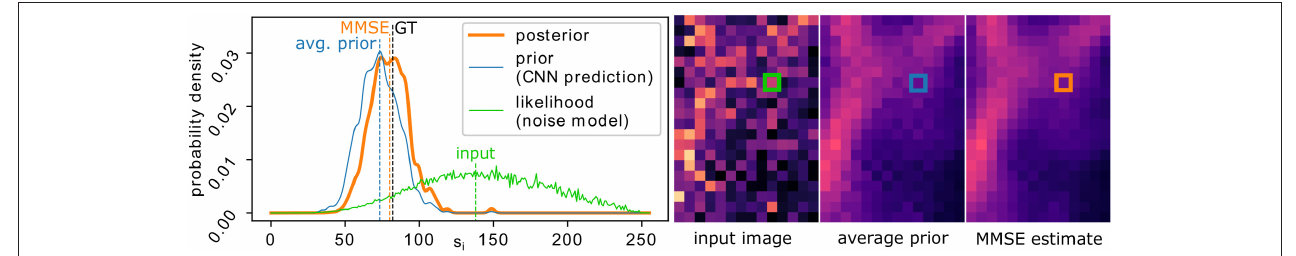
FIGURE 1 | Image denoising with PN2V. The final MMSE estimate (orange dashed line) for the true signal s i of a pixel (position marked in the image insets on the right) corresponds to the center of mass of the posterior distribution (orange curve). Given an observed noisy input value X i (dashed green line), the posterior is proportional to the product of the prior (blue curve) and the observation likelihood (green curve). PN2V describes the prior by a set of samples predicted by our CNN. The likelihood is provided by an arbitrary but measured noise model. The black dashed line indicated the true signal of the pixel (GT). Prior and posterior are visualized using a kernel density estimator.